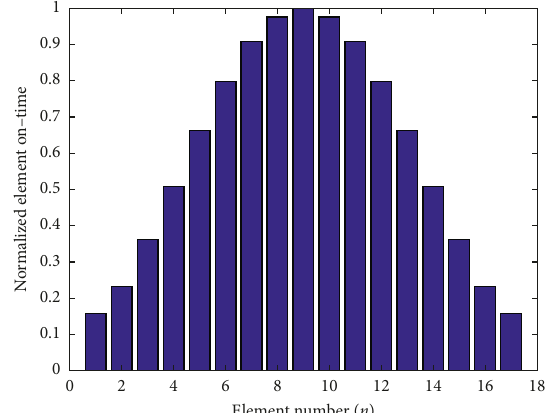
Figure 4: Histogram of normalized switch-on duration time distribution of 17-element TMSLA.